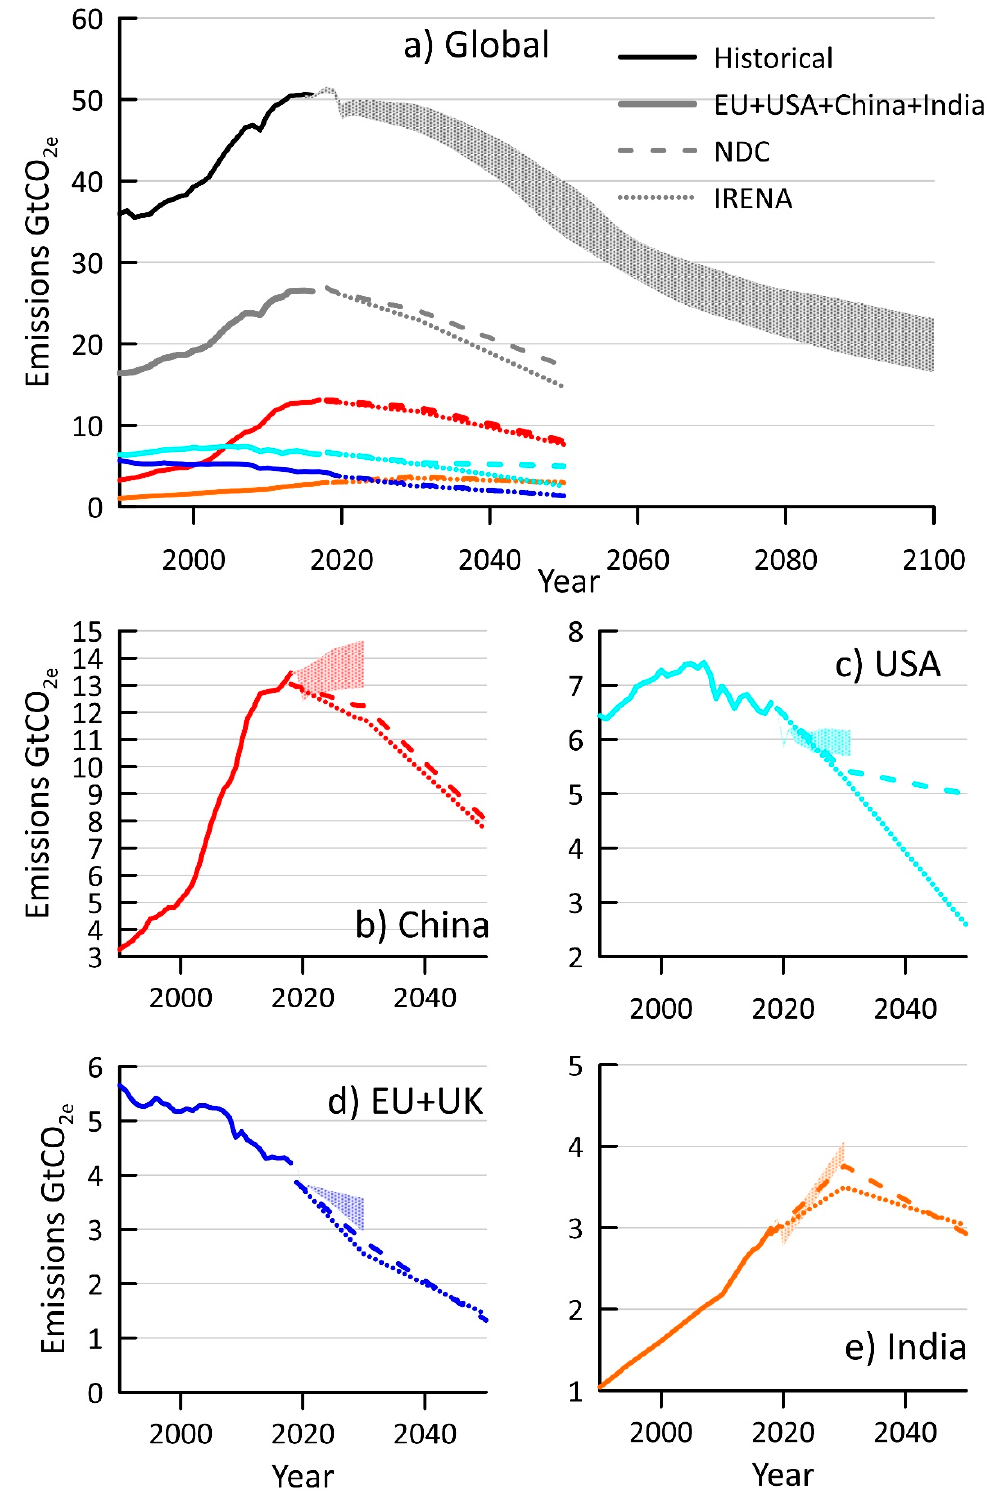
Figure 7. Annual global GHG emissions ( a ) and emissions by country/area ( b – e ) (in GtCO 2e ). NB. Axes differ in each panel, grey grid lines indicate 1 GtCO 2e per year for comparison. Solid lines show historical emissions to 2016 (global) or 2018 by country/area [36] . Shaded areas from 2016/2018 to 2030 show high/low projections based on post-COVID-19 current policies. Dashed lines indicate emissions minus wind energy contributions based on current pledges and targets from [36] . Dotted lines show emissions minus wind energy contributions estimated from IRENA [27] . Carbon emissions from [36] .